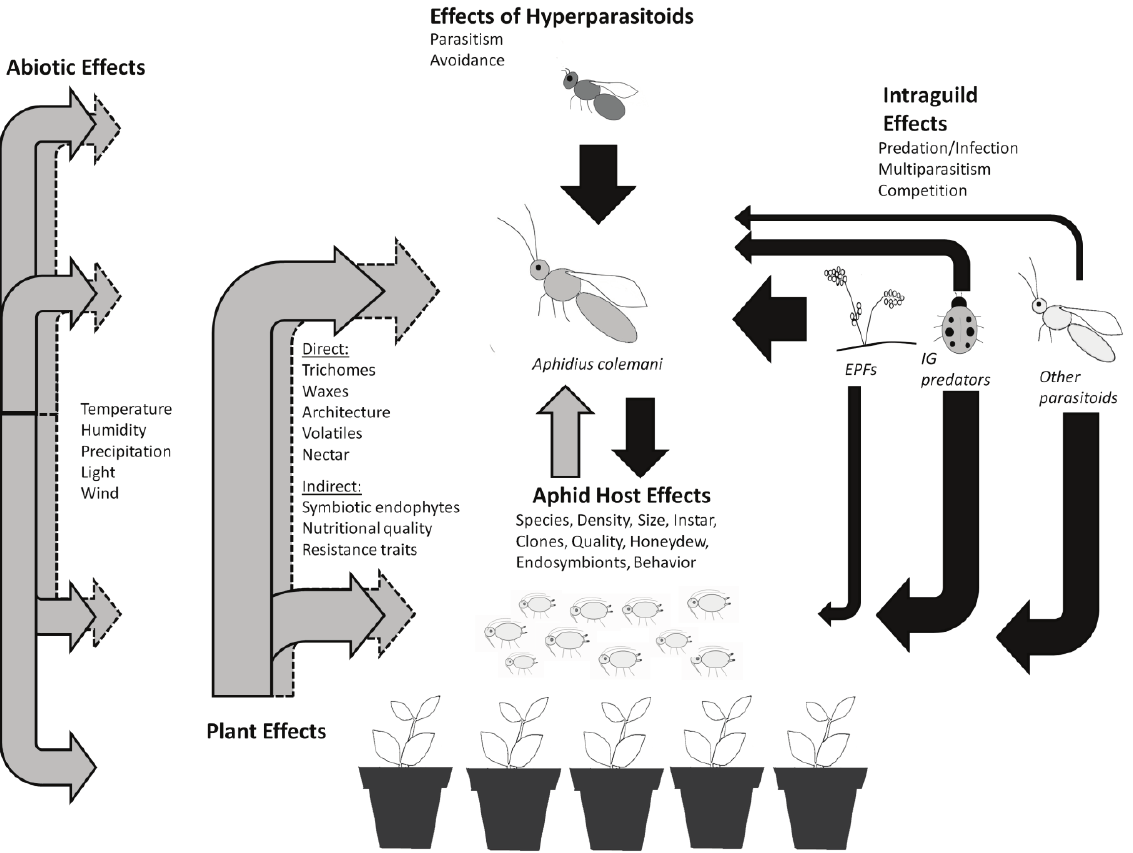
Figure 1. Ecological factors in greenhouse crops that can affect the efficacy of A. colemani and management of aphid pests. Full black arrows indicate direct negative effects on either the wasp or the pest. Full grey arrows indicate direct positive or negative effects on either the wasp or the pest. Dashed grey arrows indicate indirect positive or negative effects on either the wasp or the pest. Size of arrows approximately corresponds to size of effect, based on our literature review. EPF’s stands for entomopathogenic